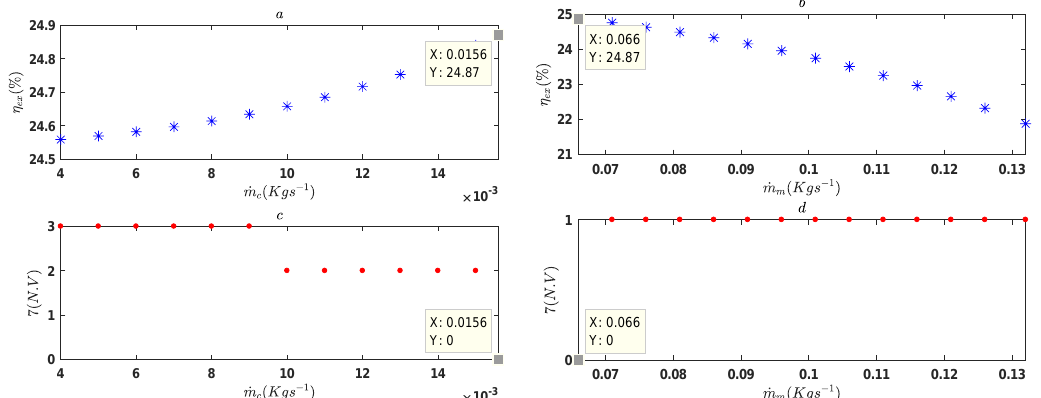
Figure 15. Variation of global exergy efficiency and number of violated constraints with compressor ( a , c ) and pneumatic motor ( b , d ) mass flow rate at optimal